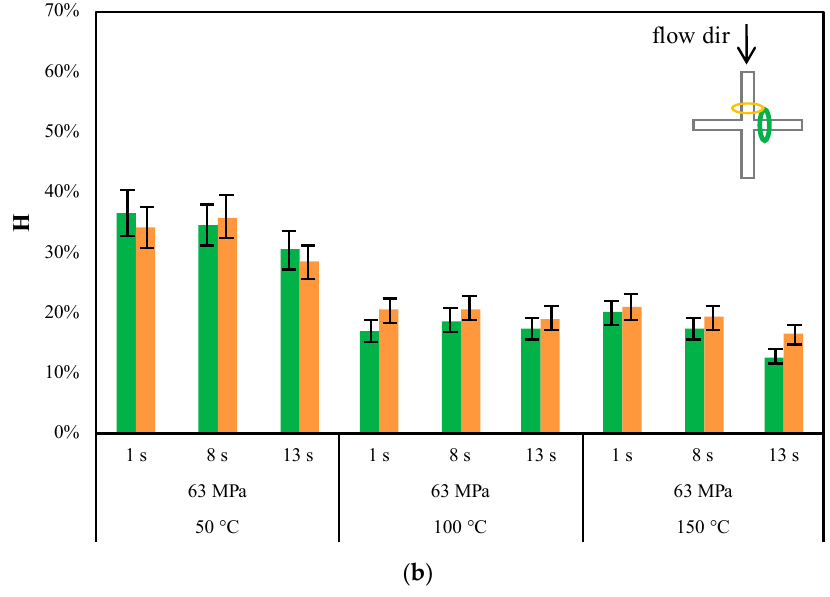
Figure 10. H index of nanofeatures on ( a ) PLA3251D samples and ( b ) PLA4032D samples obtained as indicated in Table 1. A sketch of the area where the AFM patterns have been acquired is also reported.